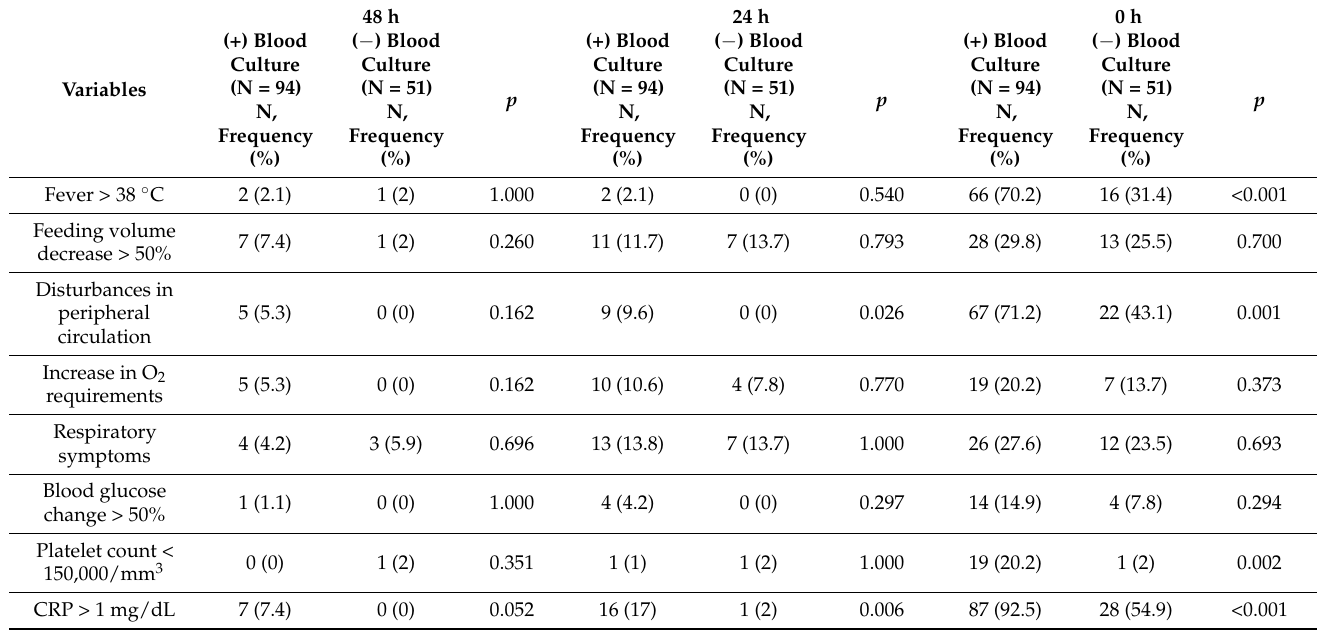
Table 4. Prospective study; each variable of the Sepsis Prediction Score in positive and negative blood culture neonates, 48 h prior, 24 h prior and on the blood culture day.